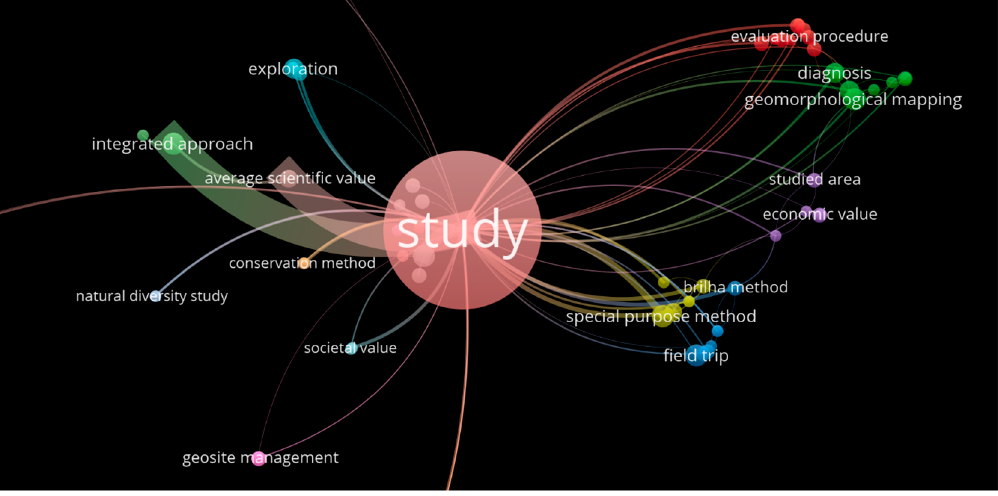
Figure 1. Global trends in methods for promoting geoconservation and geotourism.